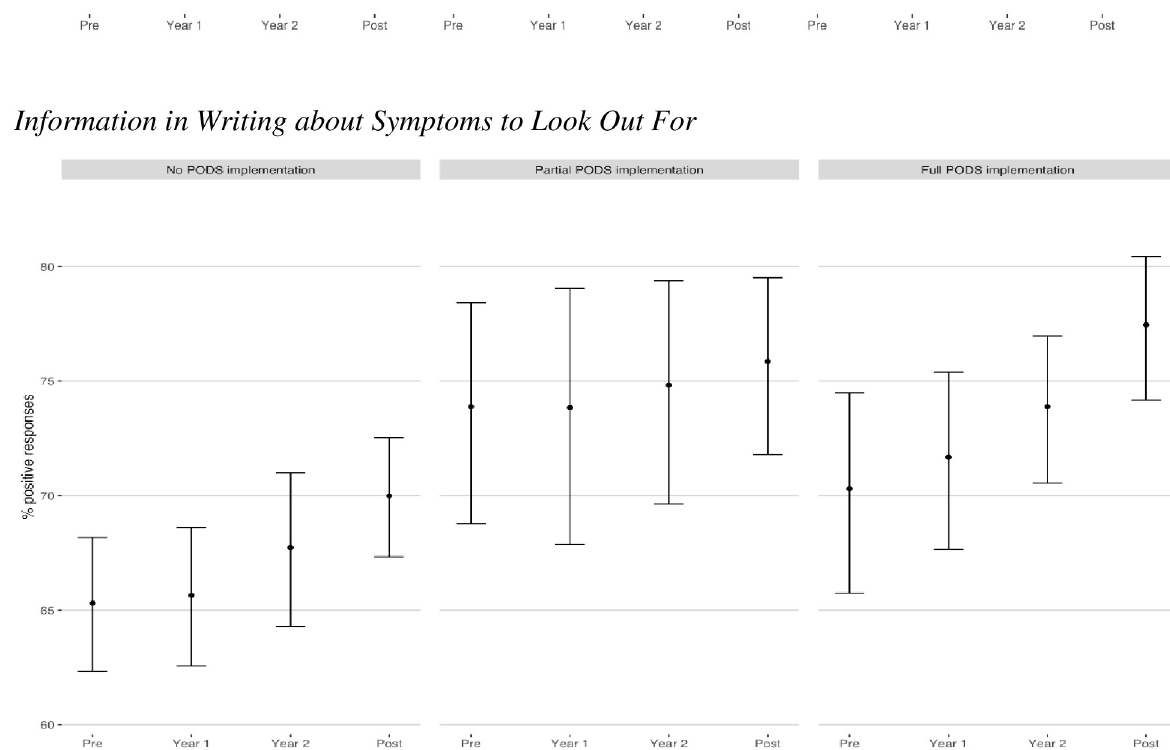
PLOS ONE | https://doi.org/10.1371/journal.pone.0268418 October 4,